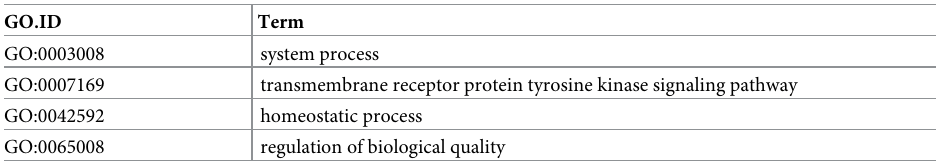
Table 7. BP GO term shared between L6L1/L6H1 and LNL1/LNH1 analyses.